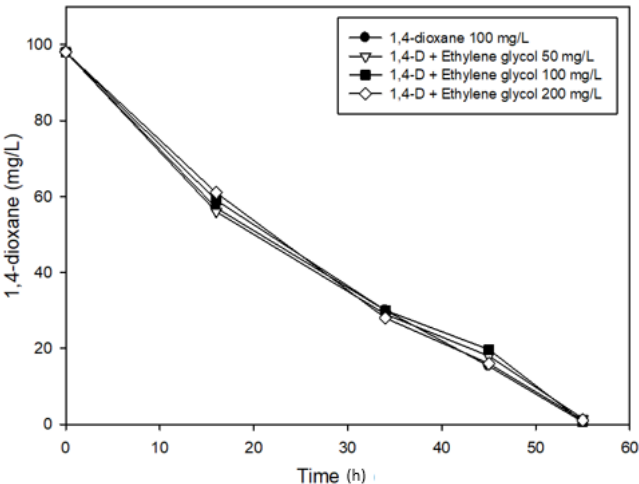
Figure 8. Biodegradation of 1,4-dioxane (1,4-D) in the presence of different ethylene glycol